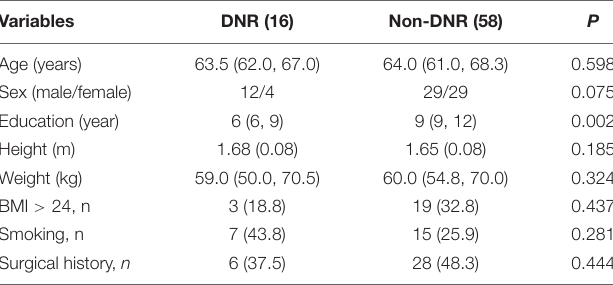
TABLE 1 | Baseline